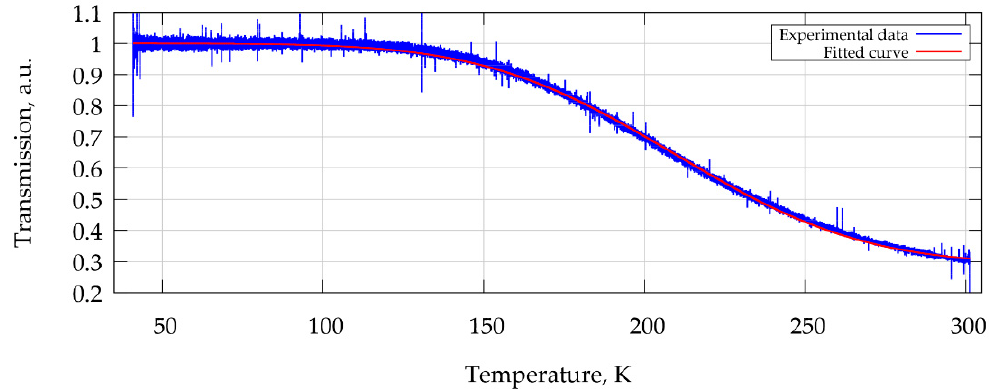
Figure 2. Dependence of the active element transmittance at 1030 nm on temperature.